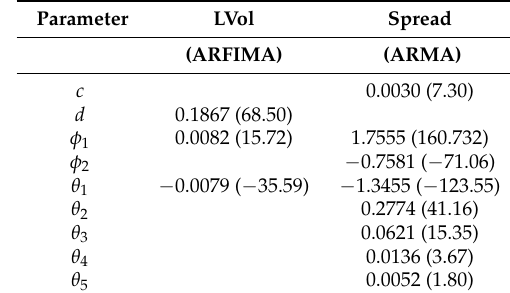
Table 6. Coefficient estimates of autoregressive model parameters fitted to selected independent variables. The t statistics are given within parentheses. Illustrative examples include a long memory and a short memory model for LVol and Sprd for the stock AGL. d , long memory parameter; φ , AR parameters; θ , MA